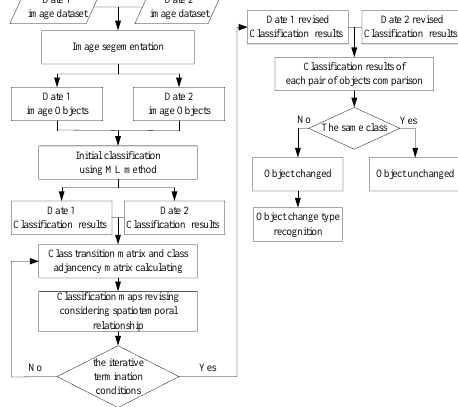
algorithm.Meyer proposed a direct